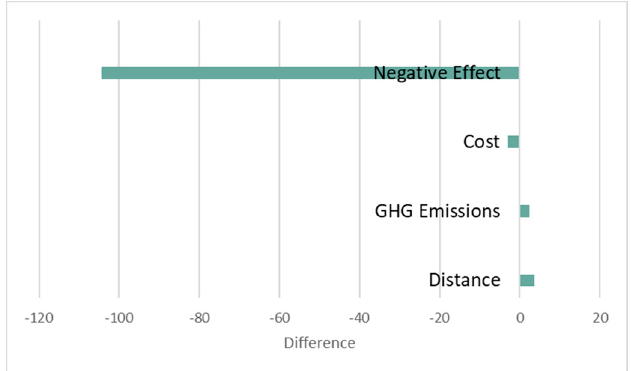
Figure 9. Differences between PCS and CS. Figure 9. Di ff erences between PCS and CS.